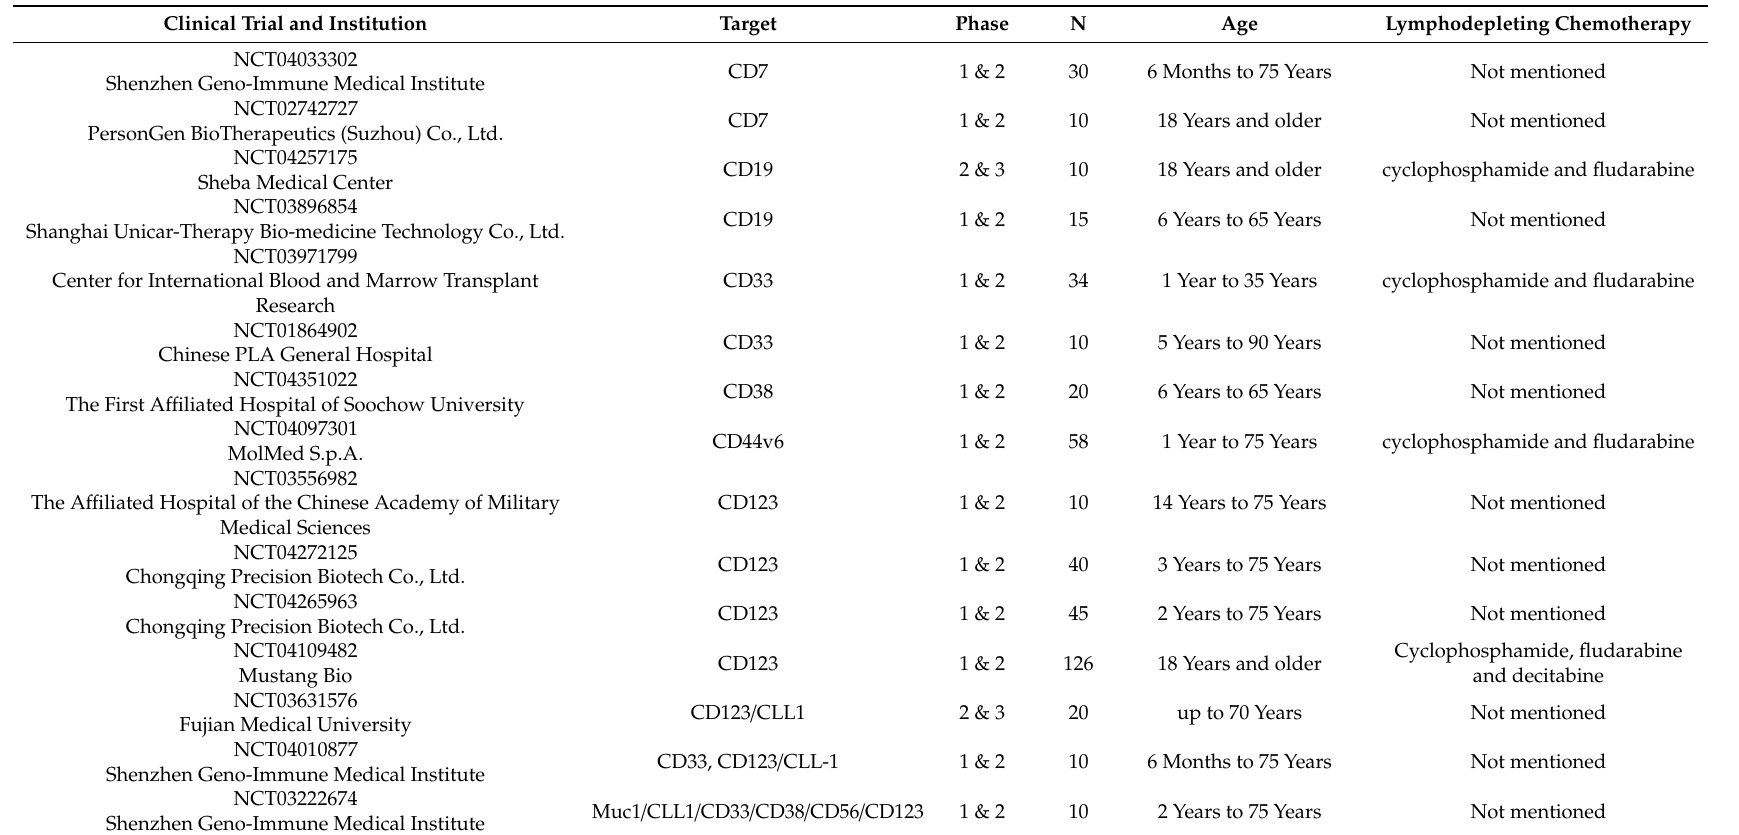
Table 2. Current CAR T-cell phase II / III clinical trials including adult relapsed / refractory acute myeloid